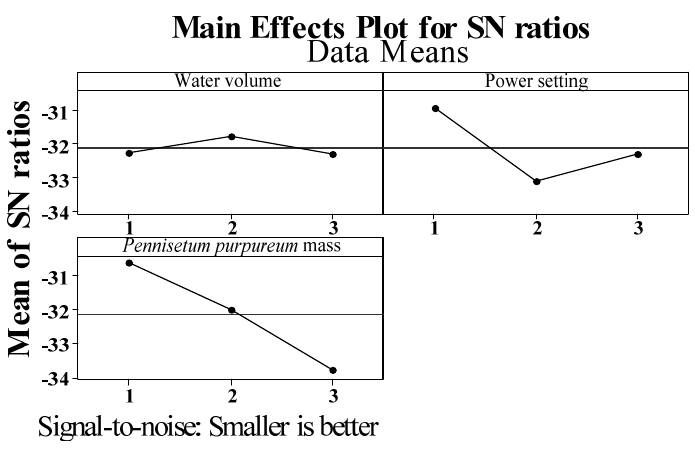
Figure 6. Response diagram of Taguchi experiments.